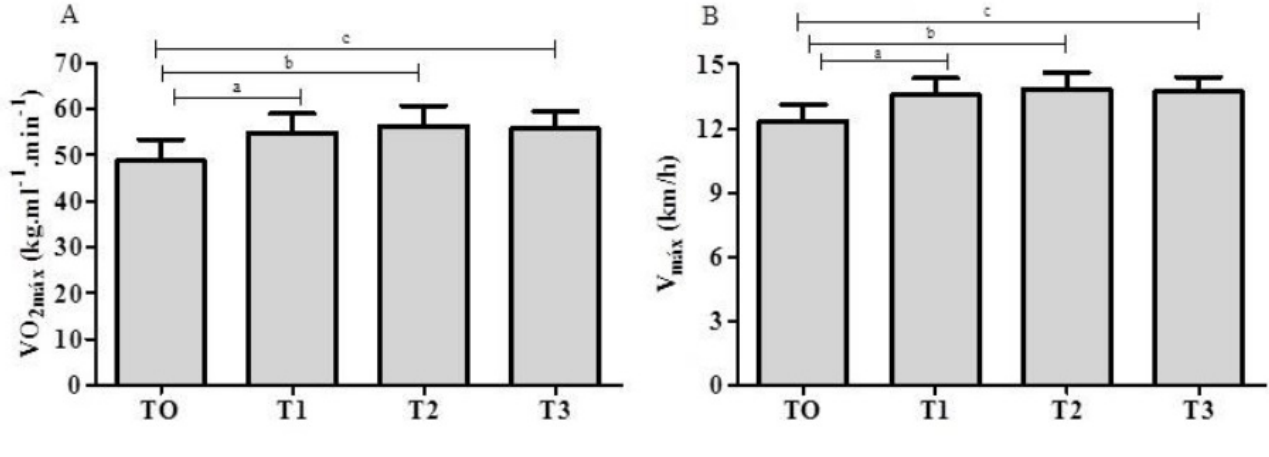
Figure 5. O2MAX and VMAX during the periodization.